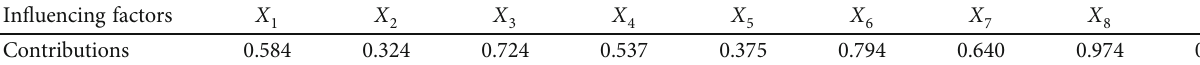
Table 5: Calculated contributions of original in fl uencing factors to the established model.